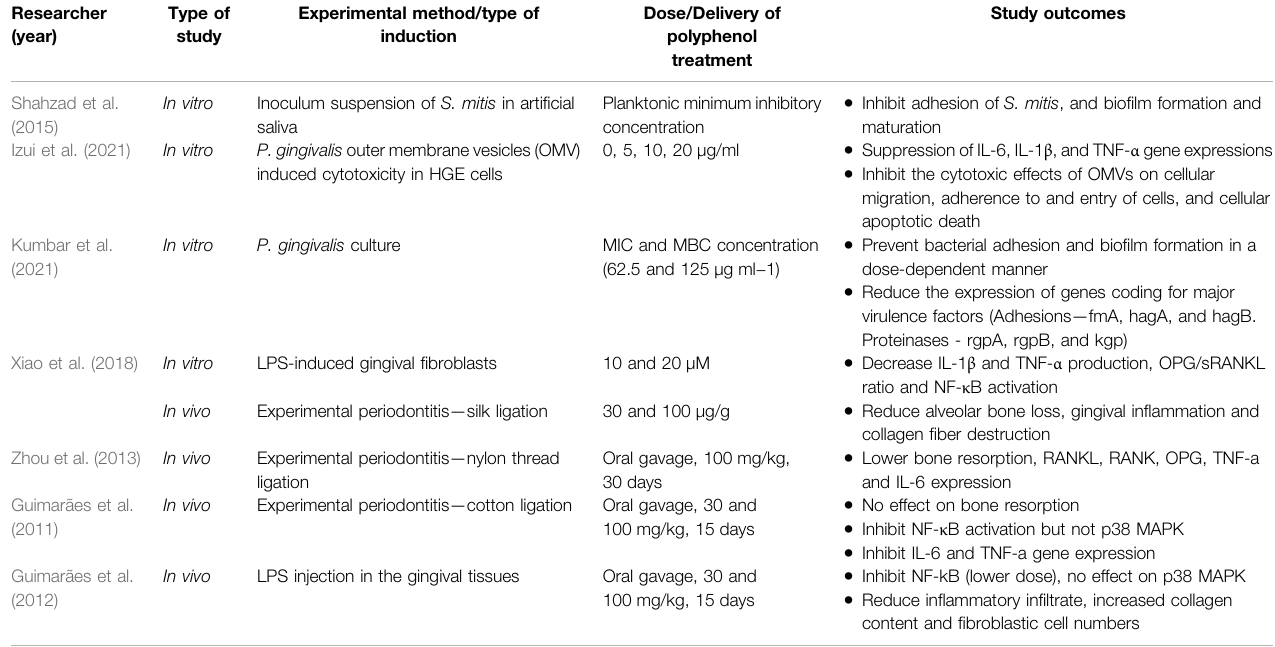
TABLE 3 | The effects of curcumin in periodontal in fl ammation, in vivo and in vitro